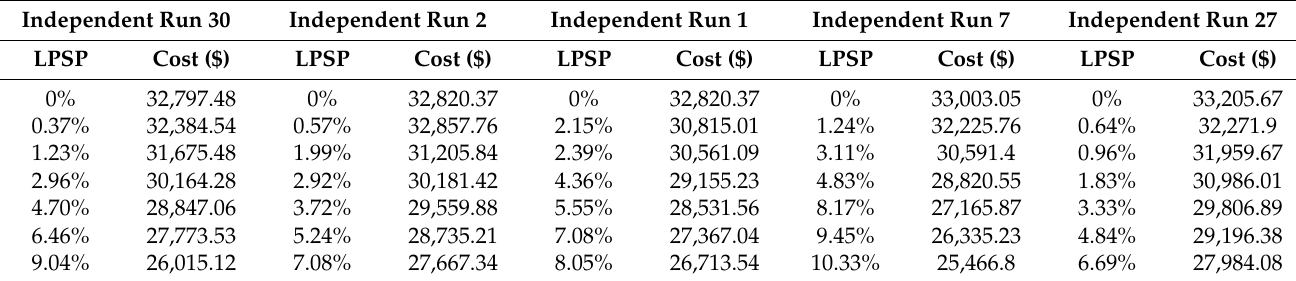
Table 6. Changes in cost due to variation of LPSP.